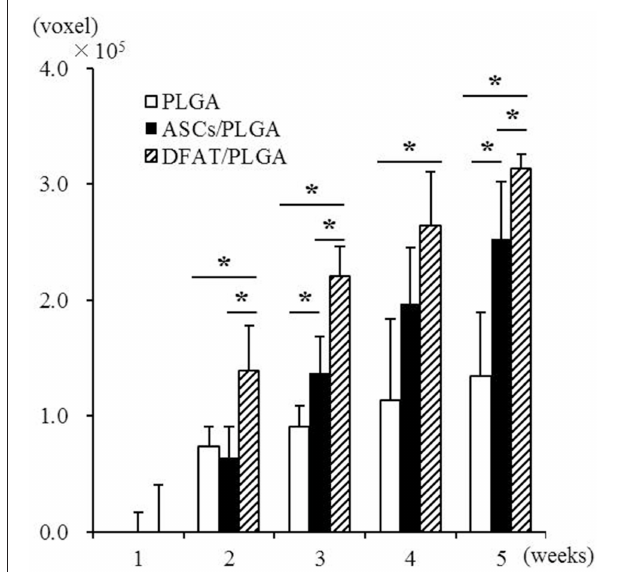
FIGURE 6 | Quantification of newly formed hard tissue regeneration using bone volume measuring software and the data from micro-CT analysis. A significant difference was observed between the DFAT/PLGA and ASCs/PLGA groups at weeks 2, 3, and 5 ( n = 12 , * P < 0.05 ).